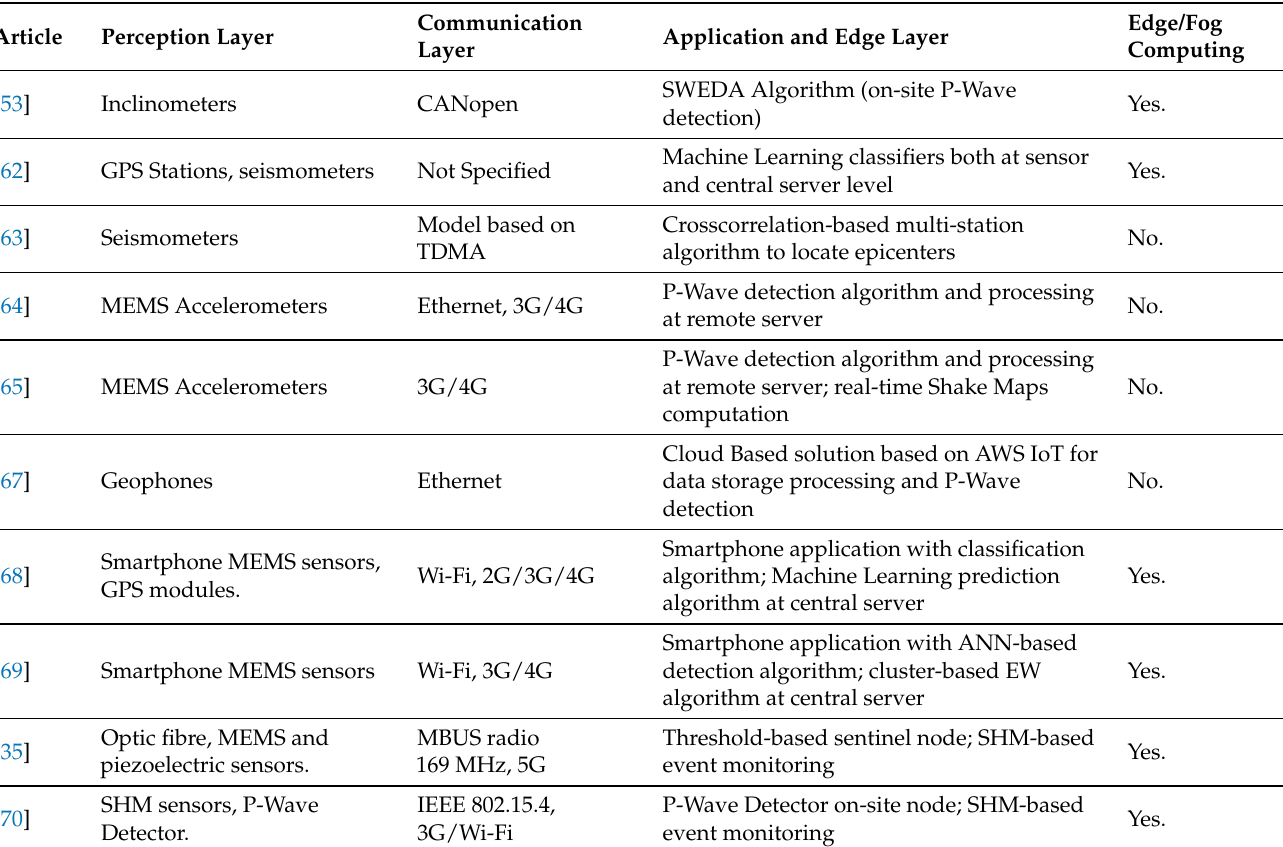
Table 4. Technologies and solutions used for each layer in the reviewed papers related to Earth- quake